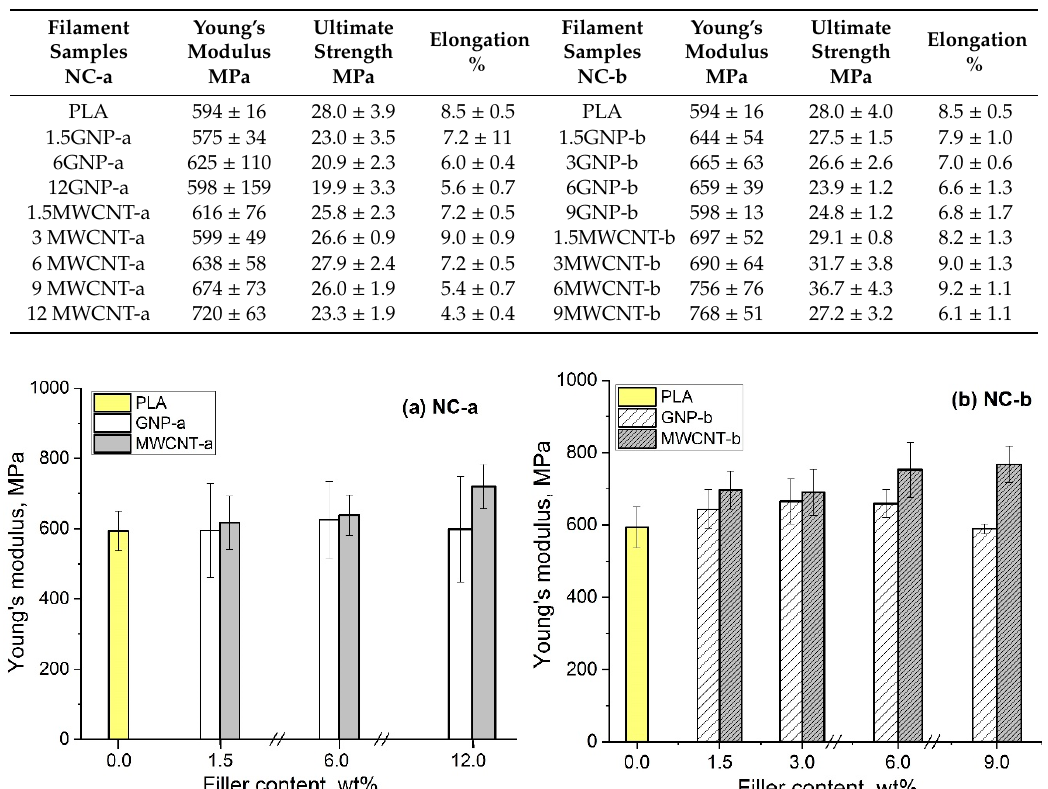
series with GNPs and MWCNTs is shown in Figure 6. Table 3. Tensile mechanical characteristics of NC-a and NC-b nanocomposites, as varying the filler contents.